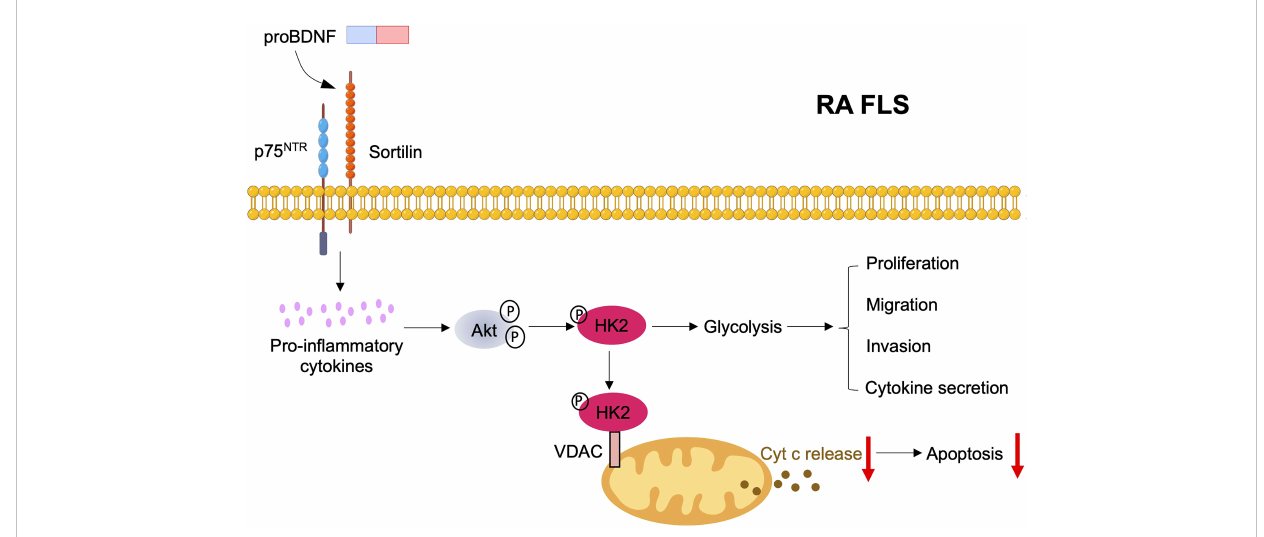
FIGURE 4 Mitochondria and glucose metabolism regulation by proBDNF/p75 NTR /sortilin signaling in RA FLS. ProBDNF/p75 NTR /sortilin signaling promotes the release of in fl ammatory cytokines, which stimulate Akt phosphorylation and then up-regulate expression and phosphorylation of hexokinase 2 (HK2). Increased binding of HK2 accompanies the phosphorylation of HK2 by Akt to mitochondrial outer membrane voltage-dependent anion channel (VDAC). Binding to VDAC enhances the af fi nity of hexokinases. Thus, HK2 mitochondria binding promotes glucose metabolism to induce FLS proliferation, migration, invasion and cytokine secretion, contributing to joint destruction in RA. Mitochondrial HK2 might also suppress FLS apoptosis by decreasing cytochrome C release from